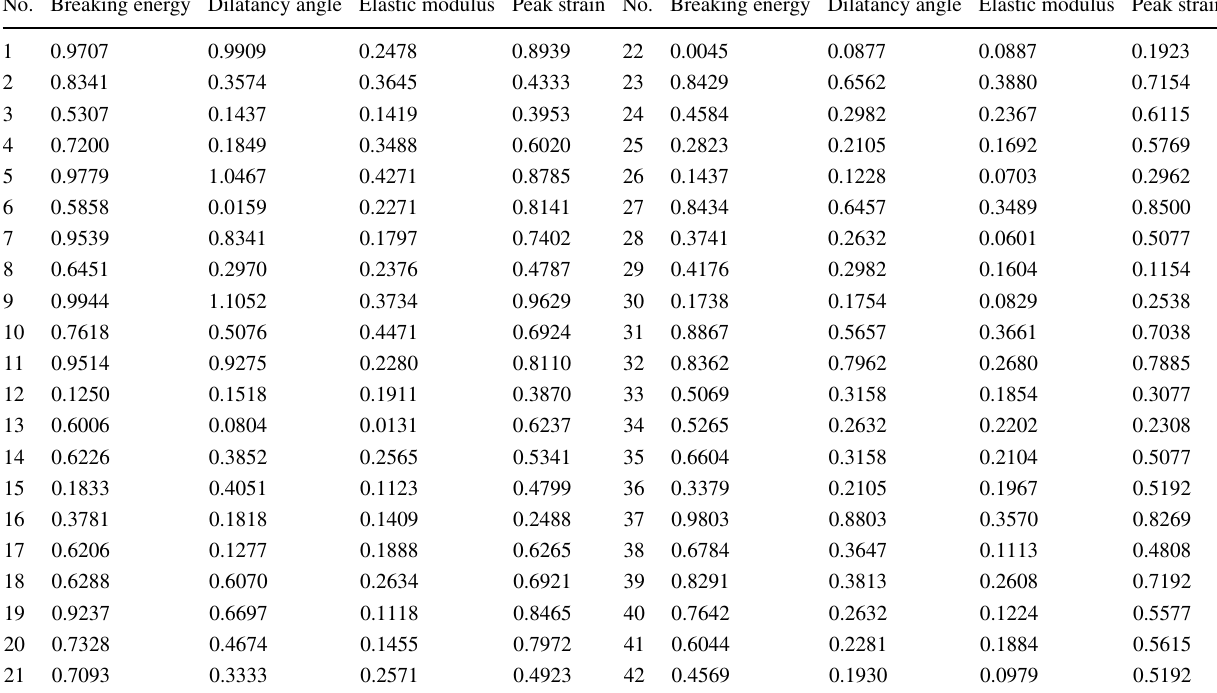
Table 2 Processing results of various parameters